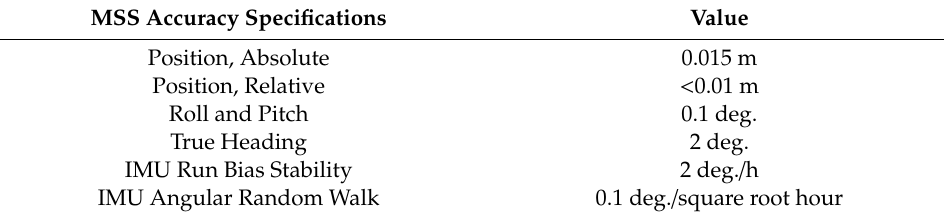
Table 2. Accuracy specifications of the adopted motion sensing system (MSS)